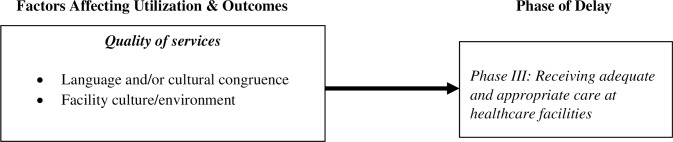
Phase III delay.